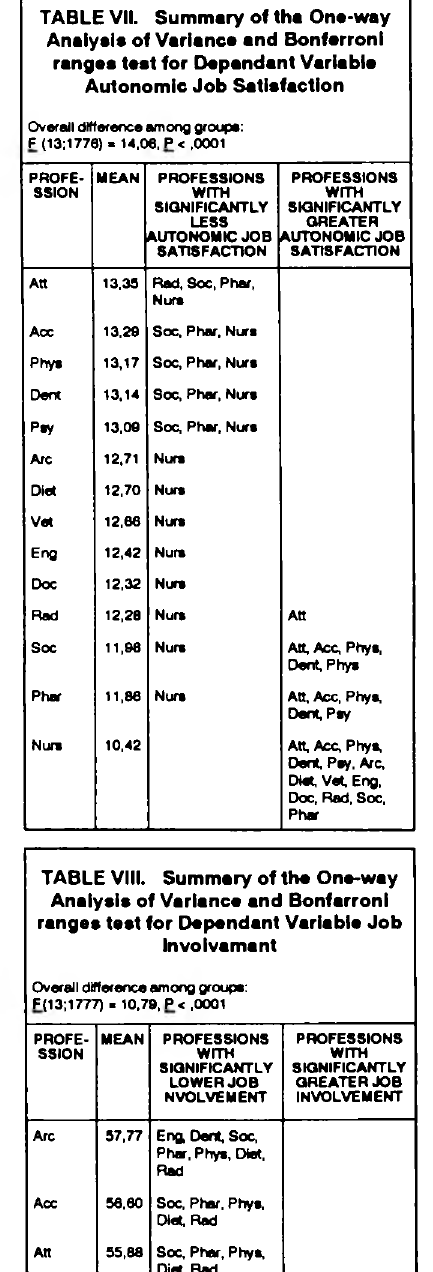
TABLE VIII. Summary of tha Ona-way Analysis of Varlanca and Bonfarronl ranges tast for Dapandant Variabla Job Involvamant Overall difference among groups: F(13;1777) - 10,79, P < ,0001 MEAN PROFESSIONS PROFE­ WITH SSION